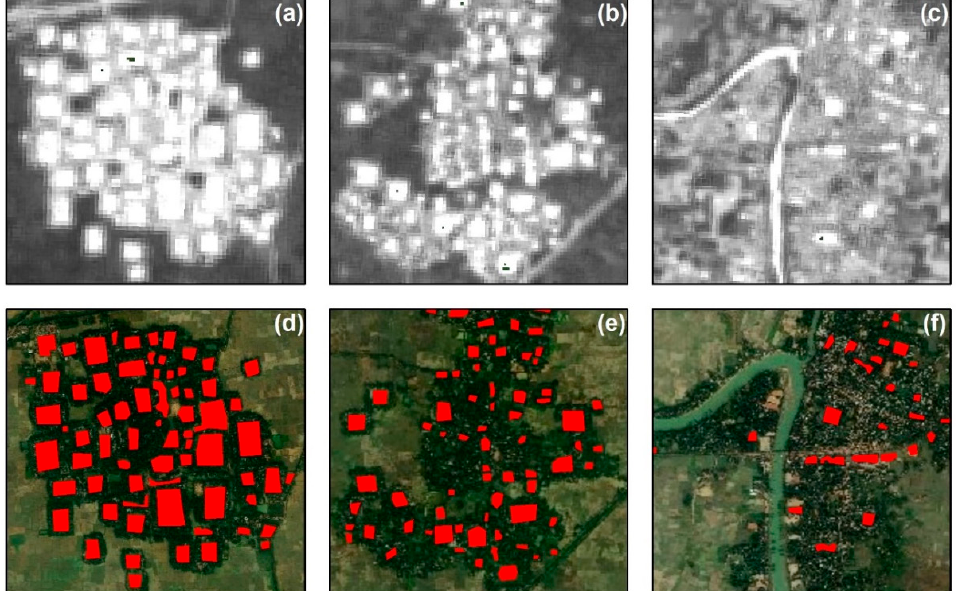
Table 5. Coefficients of OBFs using the optimal LR model.